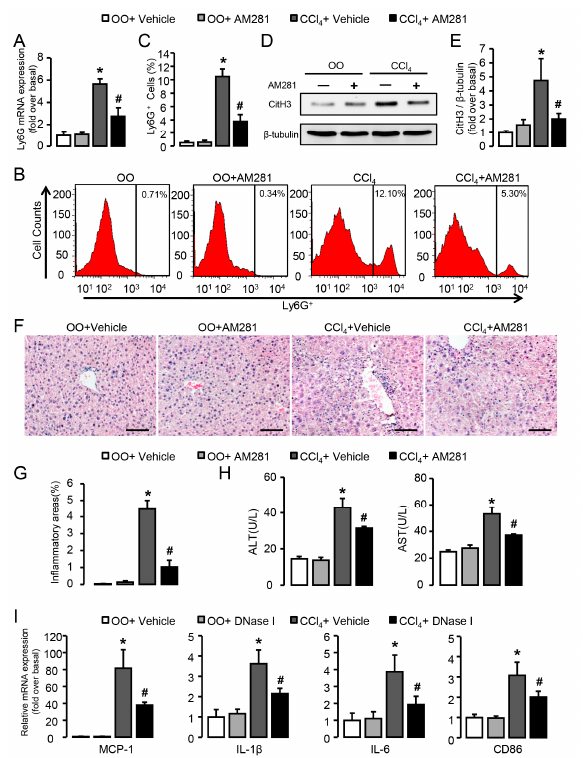
Figure 6. Blockade of CB1 significantly attenuates neutrophil infiltration and liver inflammation in CCl 4 -treated mice. ( A ) Ly6G mRNA expression in CCl 4 - or olive oil (OO)-treated liver with or without the administration of AM281. ( B , C ) Representative FACS plots and quantification for neutrophils in liver. ( D , E ) CitH3 protein levels in liver. ( F ) Representative H&E staining images of liver sections. Scale bars, 100 µm. ( G ) Quantitative analysis of liver inflammation areas. ( H ) Alanine aminotransferase (ALT) and aspartate aminotransferase (AST) levels were detected by chemistry analyzer. ( I ) mRNA expression of MCP-1, IL-1 β , IL-6, and CD86 in CCl 4 - or OO-treated liver with or without the administration of DNase I. Data are presented as the mean ± SEM. N = 6 per group. * P < 0.05 vs. OO. # P < 0.05 vs. CCl 4 -treated alone.